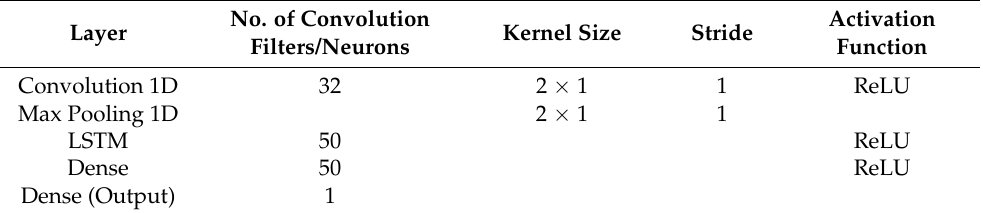
Table 5. Layer configuration of the multivariate CNN-LSTM model.